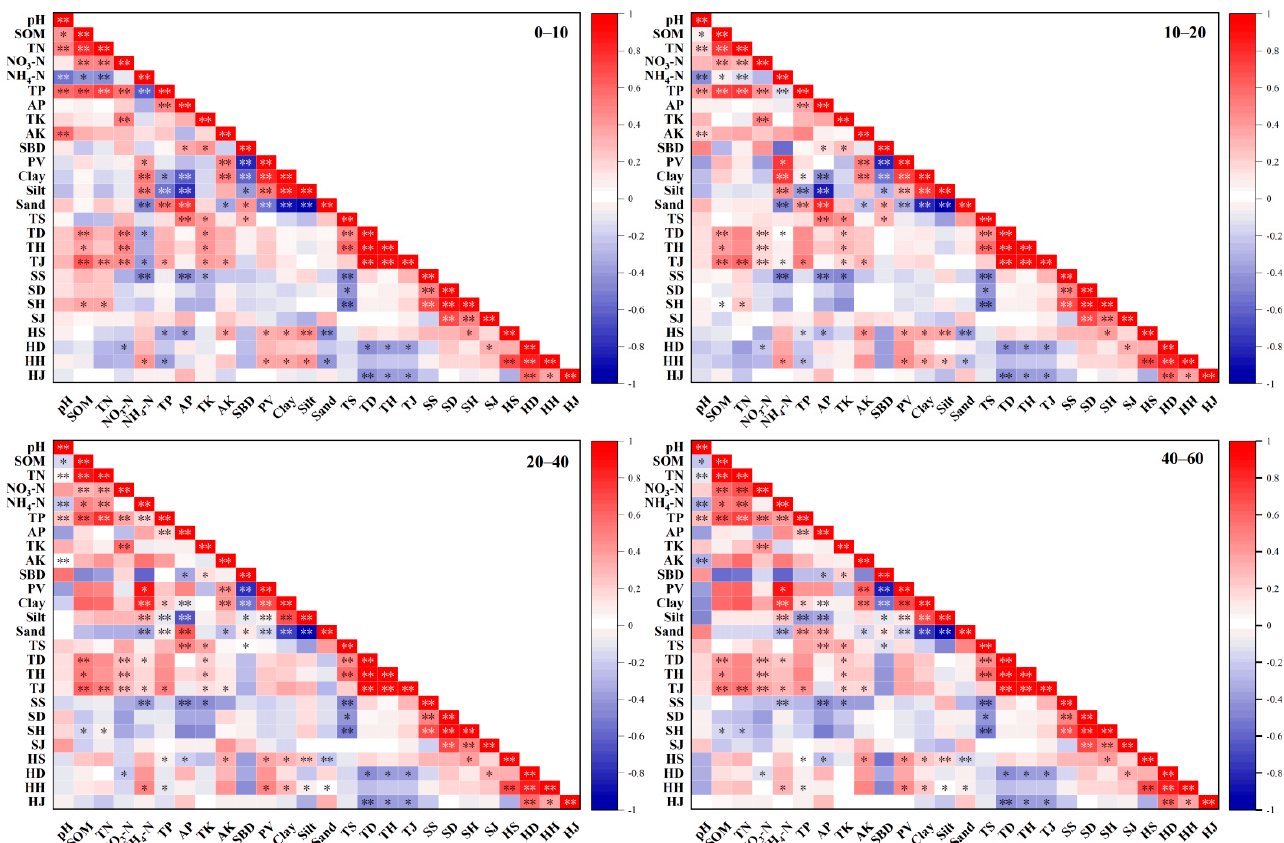
Figure 3. Correlation analysis between soil physicochemical properties and plant diversity indexes.